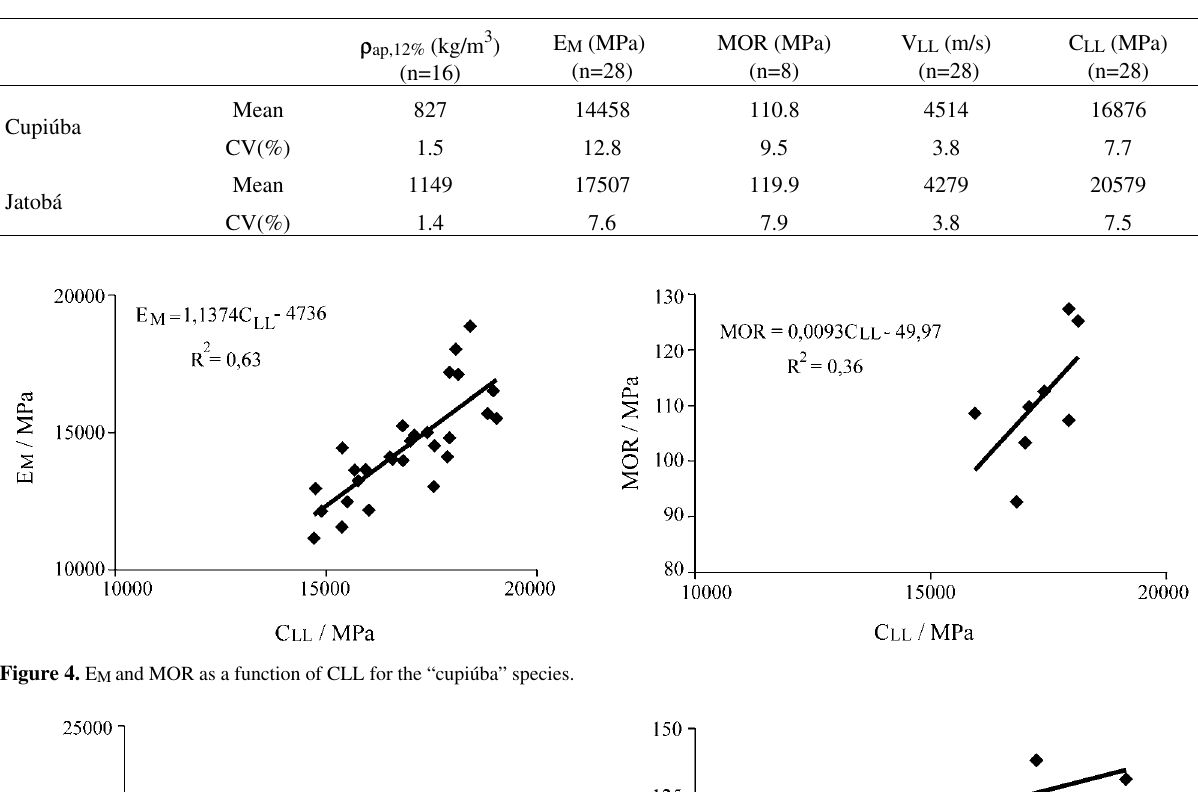
Table 1. Mean values and coefficients of variation.